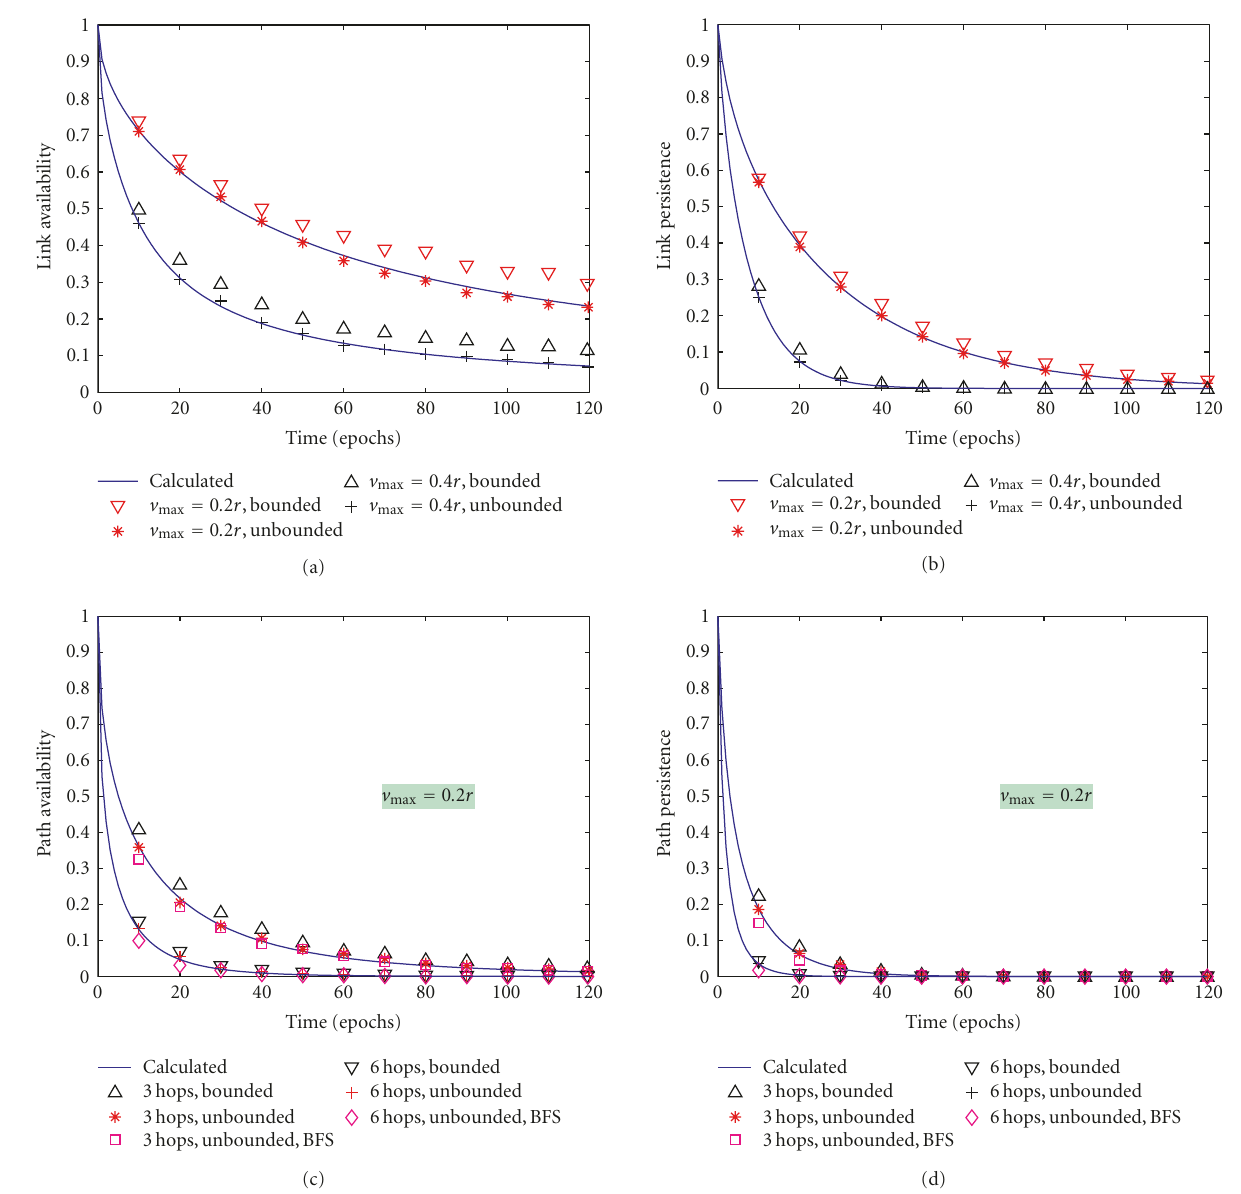
Figure 6: Comparison of metric calculations and simulated results for link (path) availability and link (path) persistence. Each MN moves at a randomly chosen velocity during each epoch, which has uniformly distributed speed in the range [0, v max ], and uniformly distributed direction in the range [0,2 π ). (a) Comparison of calculated and experimental link availability values for both bounded and unbounded simulation areas. Calculated values are from (23). (b) Comparison of calculated and experimental link persistence values for both bounded and unbounded simulation areas. Calculated values are from (24). (c) Comparison of calculated and experimental path availability values for bounded and unbounded simulation areas and the BFS algorithm. Calculated values are from (35). (d) Comparison of calculated and experimental path persistence values for bounded and unbounded simulation areas and the BFS algorithm. Calculated values are from (37).